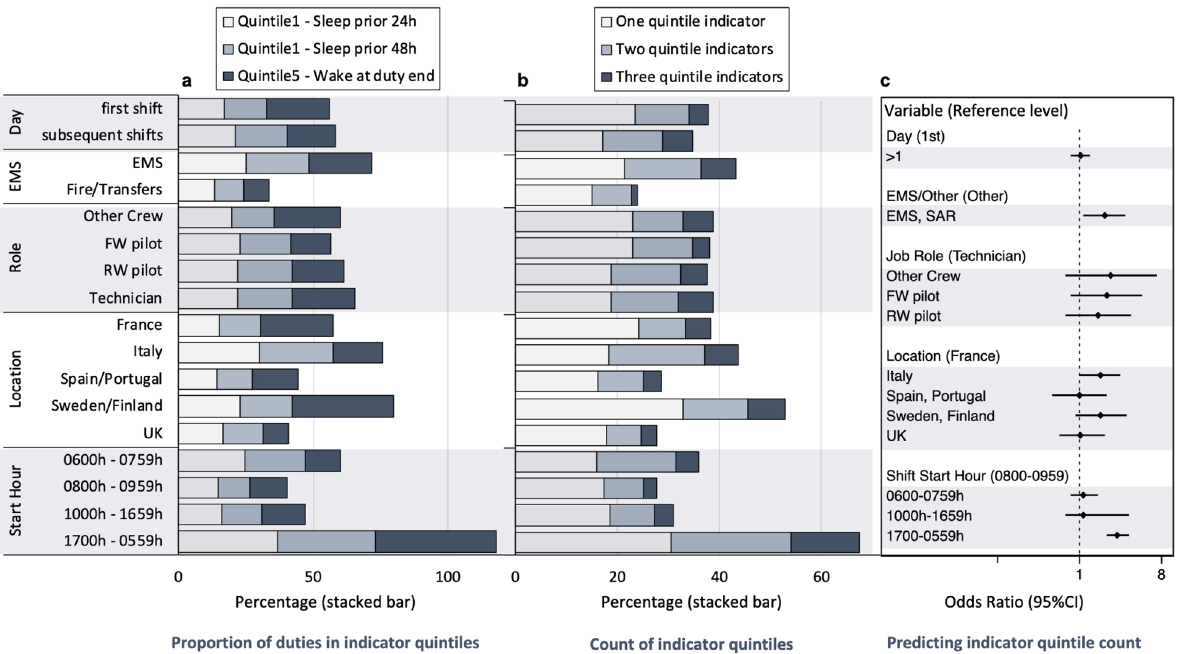
Figure 7. The odds of membership of multiple sleep and wake fatigue indicator quintiles (lowest quintiles for sleep in the prior 24 h and 48 h, and highest quintile for wake at duty end) are higher for EMS and SAR operations, and for duties starting in the evening and overnight. Stacked bar chart showing percentage of duties with prior sleep values in the lowest quintile and wake at the end of duty values in the highest quintile (panel a ). Stacked bar showing percentage of duties that fall into one, two, or three indicator quintiles (panel b ). Forest plot showing predictors of membership of multiple indicator quintiles for sleep and wake (0–3) by Location, Operation (EMS/SAR, Fire/Transfers), Shift Start Hour, Day, and Role (panel c ). Note: EMS = Emergency Medical Service, Fire = Firefighting, Transfers = Air Taxi, SAR = Search and Rescue, FW = Fixed Wing, RW = Rotary Wing, Tech =